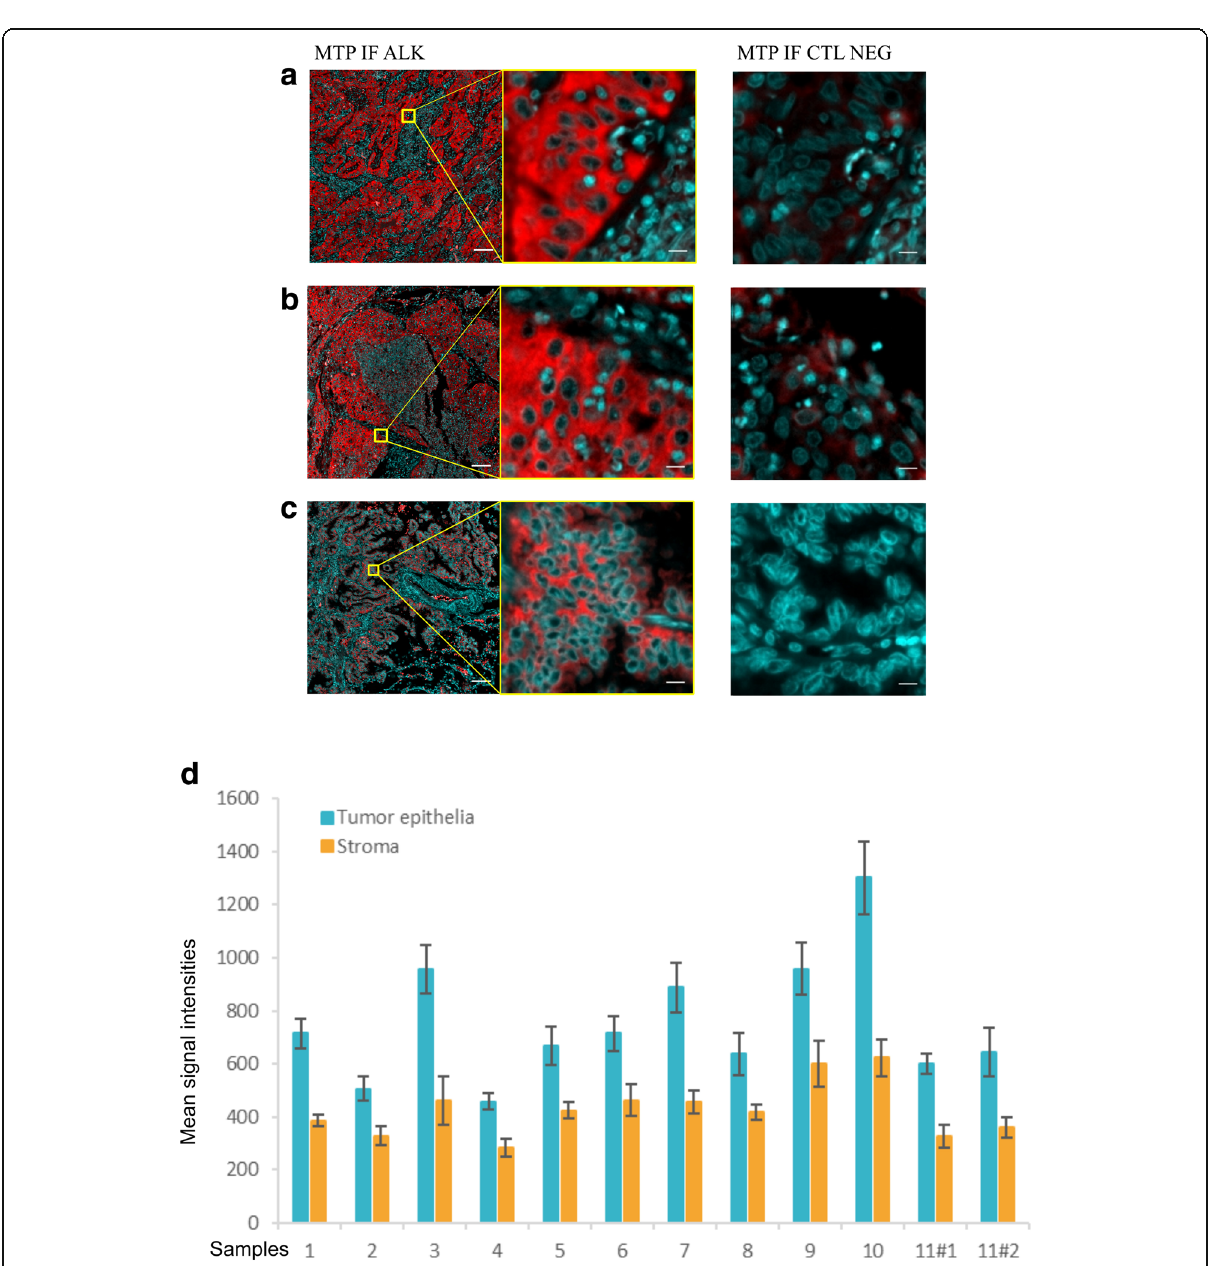
Fig. 3 Variation of ALK immunoreactivity in a series of 12 lung adenocarcinomas. Three representative cases of microfluidic-based ALK IF (MTP IF ALK) are shown in a Case N°10, b Case N°7 and c Case N°3. Scale bars are 100 μ m and 10 μ m for the first and second column, respectively. The third column represents the negative control (CTL NEG) where PBST 0.05% was used instead of the primary antibody. The shown region of interest for the negative control is the same as for ALK IF; scale bar is 10 μ m. d Quantification of the ALK IF signals. For each case, 25 ROIs were manually placed in both ALK+ tumor epithelia and stroma regions. The graph shows the average of the mean intensities of all 25 ROIs for tumor epithelia (blue) and stroma (orange) with corresponding standard deviations. Case N°11 is present twice (11#1 and 11#2) as two samples with distinct localization (lung primary and parietal pleura, respectively) were obtained from the same